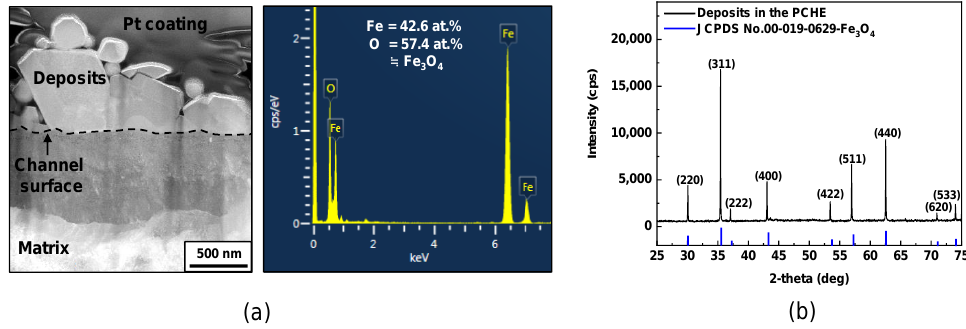
Figure 7. Chemical composition and crystal structure of the deposits within the PCHE: ( a ) STEM image and EDS spectra, and ( b ) XRD patterns.